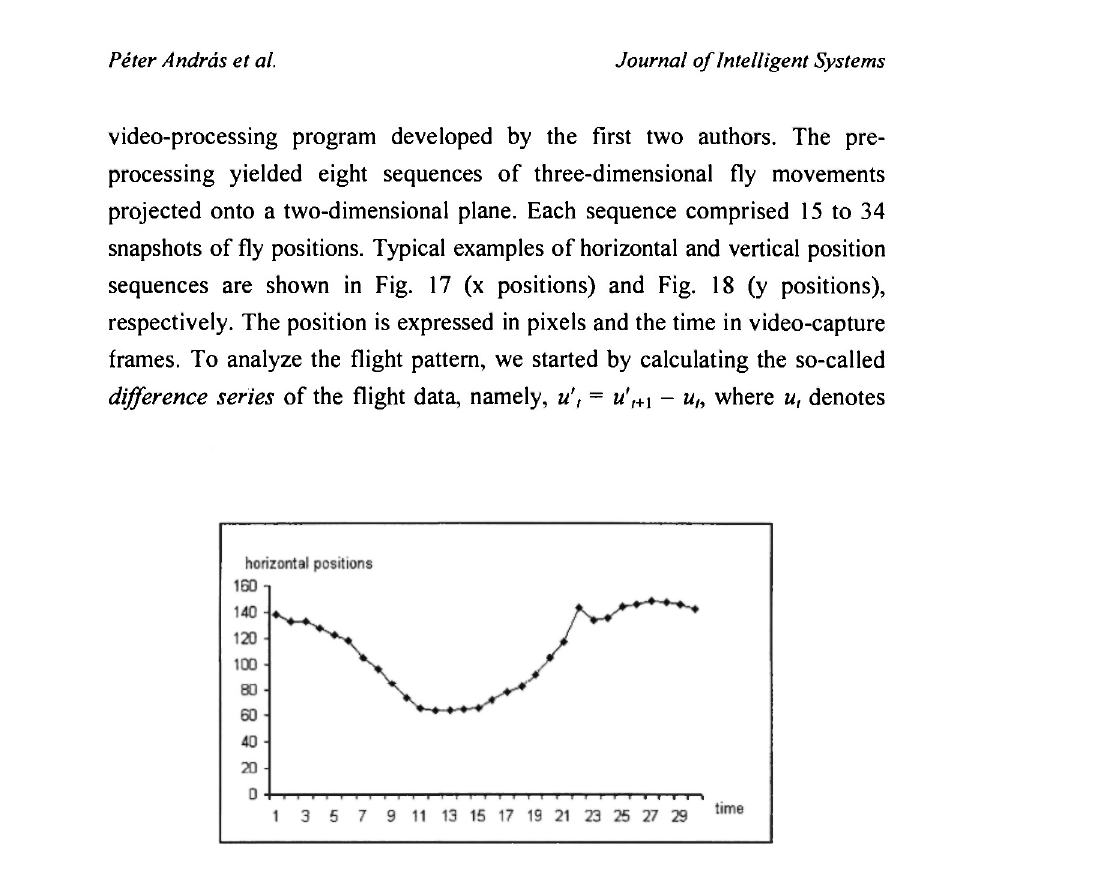
Fig. 17: The horizontal positions of the fly as a function of time (the time is measured in video-capture frames).